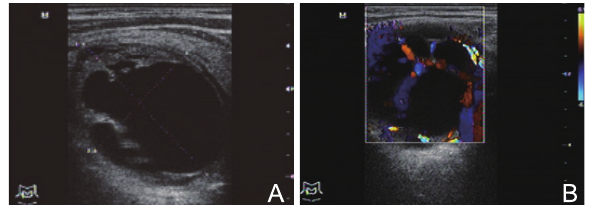
Figure 1 A sagittal view of ultrasound scan demonstrated a thin-walled cystic lesion of 40×30mm in size on the dorsal side of the right lobe of his thyroid gland, with well-defined border and thicken separation. B Abundant blood flow signals were seen on the wall and thick separation.